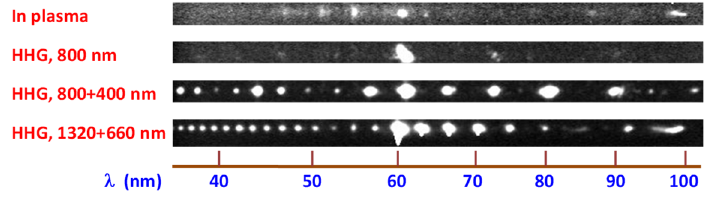
Figure 6. Raw images of plasma and harmonic spectra from the indium ablation. Upper panel: Plasma emission in the case of the over-excitation of In target. Second panel: HHG spectrum using SCP (800 nm, Laser1) at optimal ablation of target. Third panel: HHG spectrum using OTC (800 + 400 nm, Laser1). Fourth panel: HHG spectrum using OTC (1320 + 660 nm, Laser2).